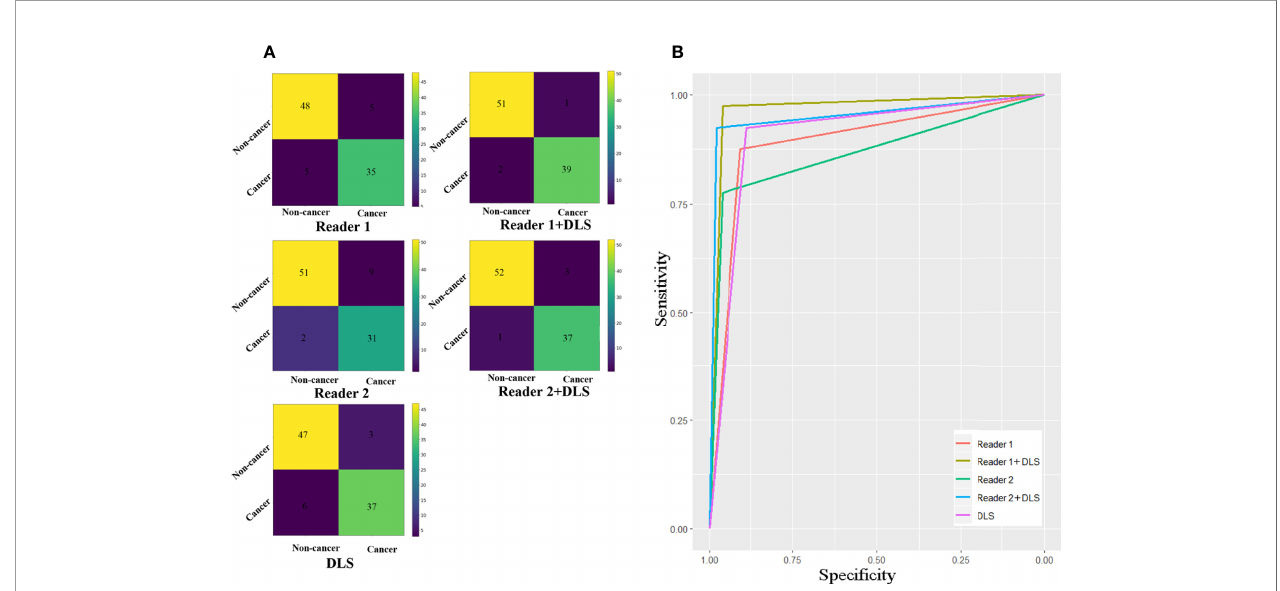
FIGURE 3 | Confusion matrixes (A) and ROC curves (B) for the fi ve classi fi cation methods. The AUC of Reader1+DLS and Reader2+DLS are signi fi cantly higher than the AUC of Reader1, Reader2, and DLS (all P < 0.05). DLS, deep learning system; ROC, receiver operating characteristic; AUC, area under the ROC curve.